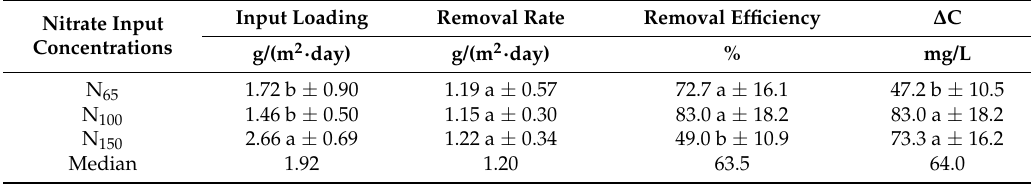
Table 1. Nitrate as nitrogen (NO 3 -N) removal rate, removal efficiency and ∆ C (difference between nitrate input and effluent concentrations), mean ± standard deviation, for different nitrate input concentrations: N 65 (65 mg/L); N 100 (100 mg/L); N 150 (150 mg/L). Two groups that are identified by the same letter (a, b, or c) are not significantly different from each